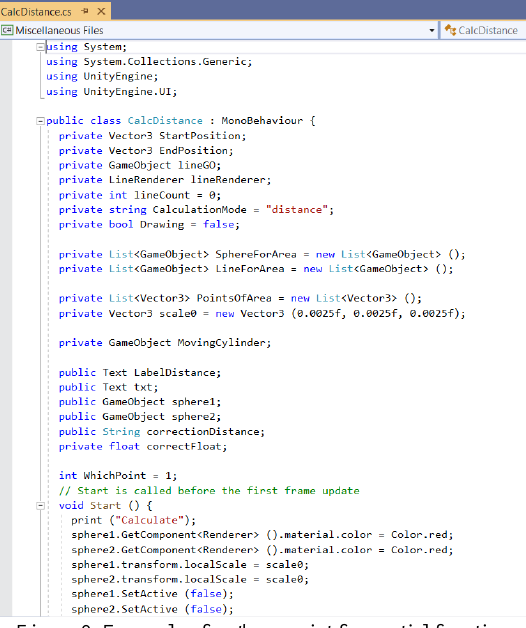
Figure 9. Example of python script for spatial function (calculating distance)